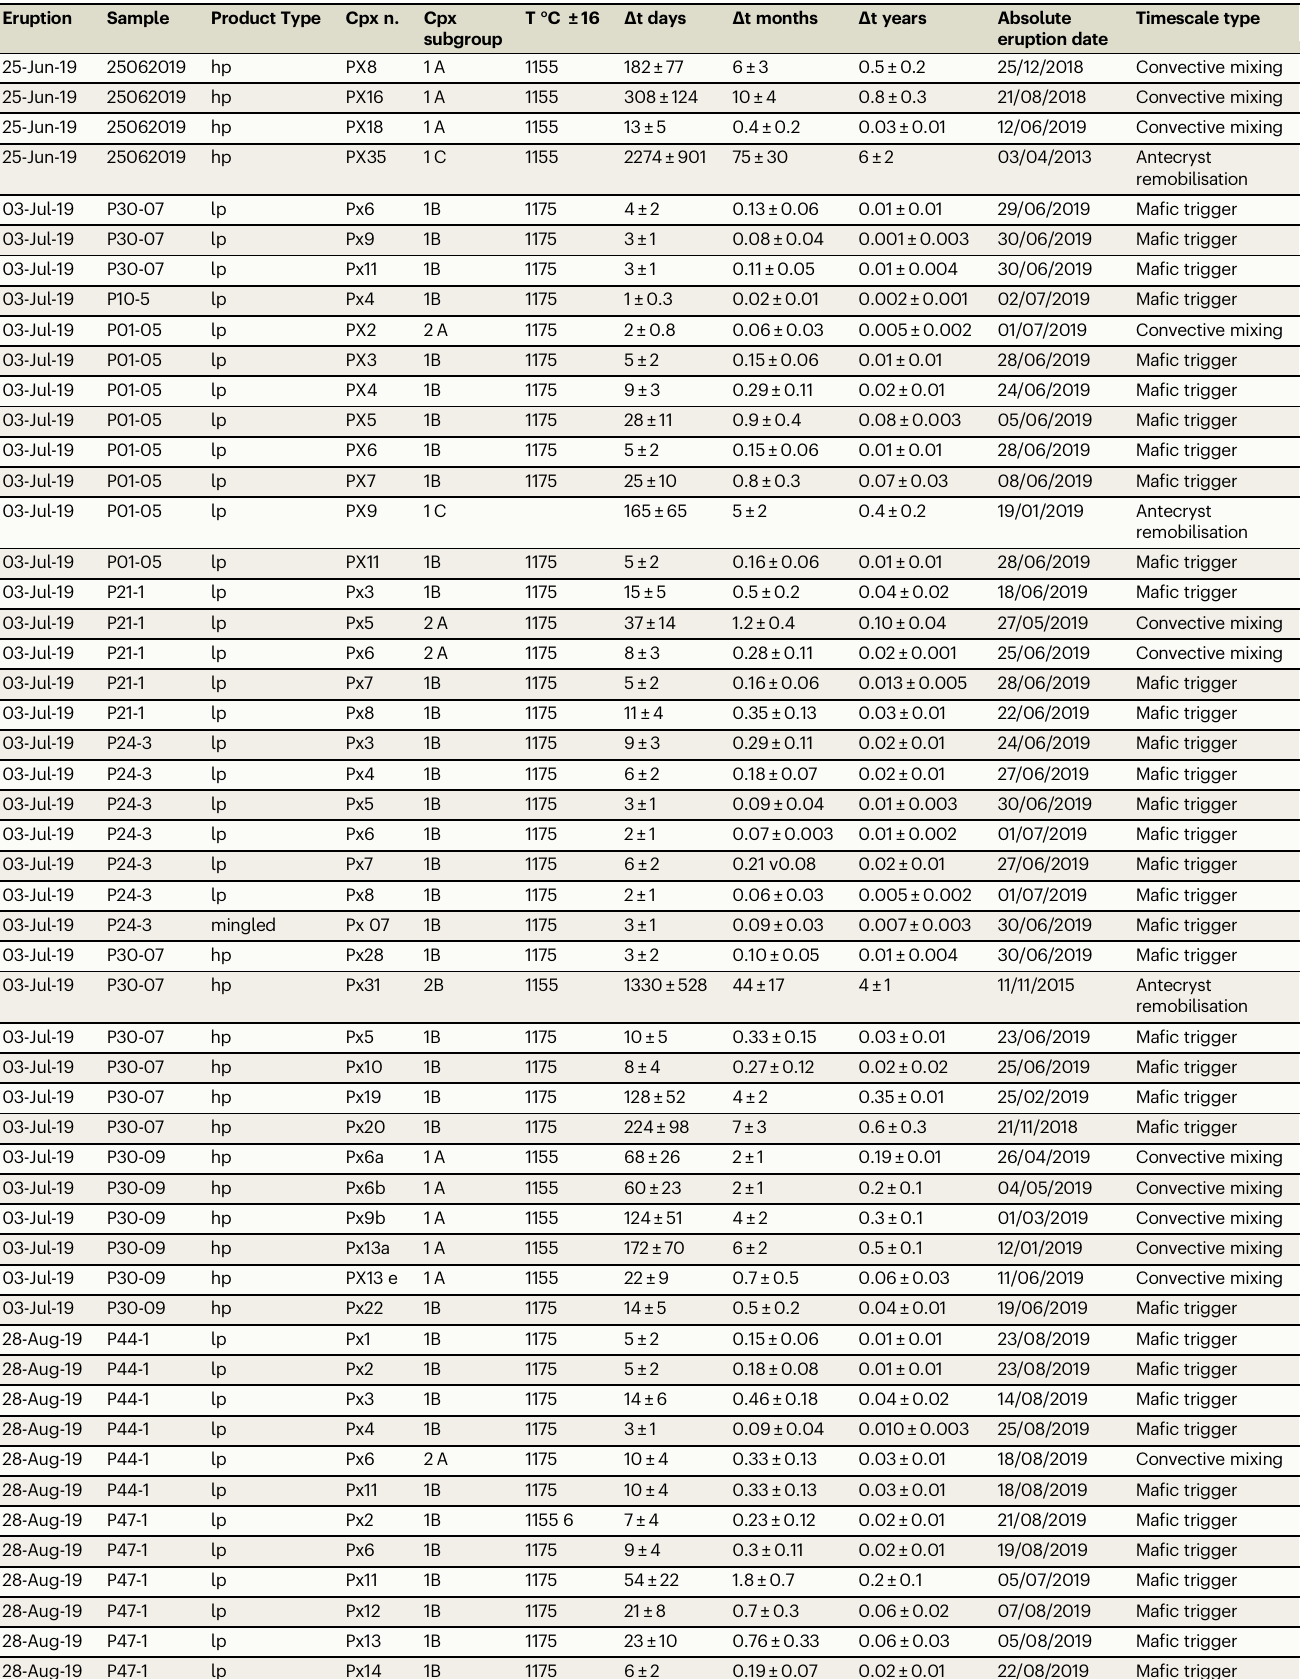
Table 1 | Fe-Mg timescales calculated for clinopyroxenes from 2019 eruptions Eruption